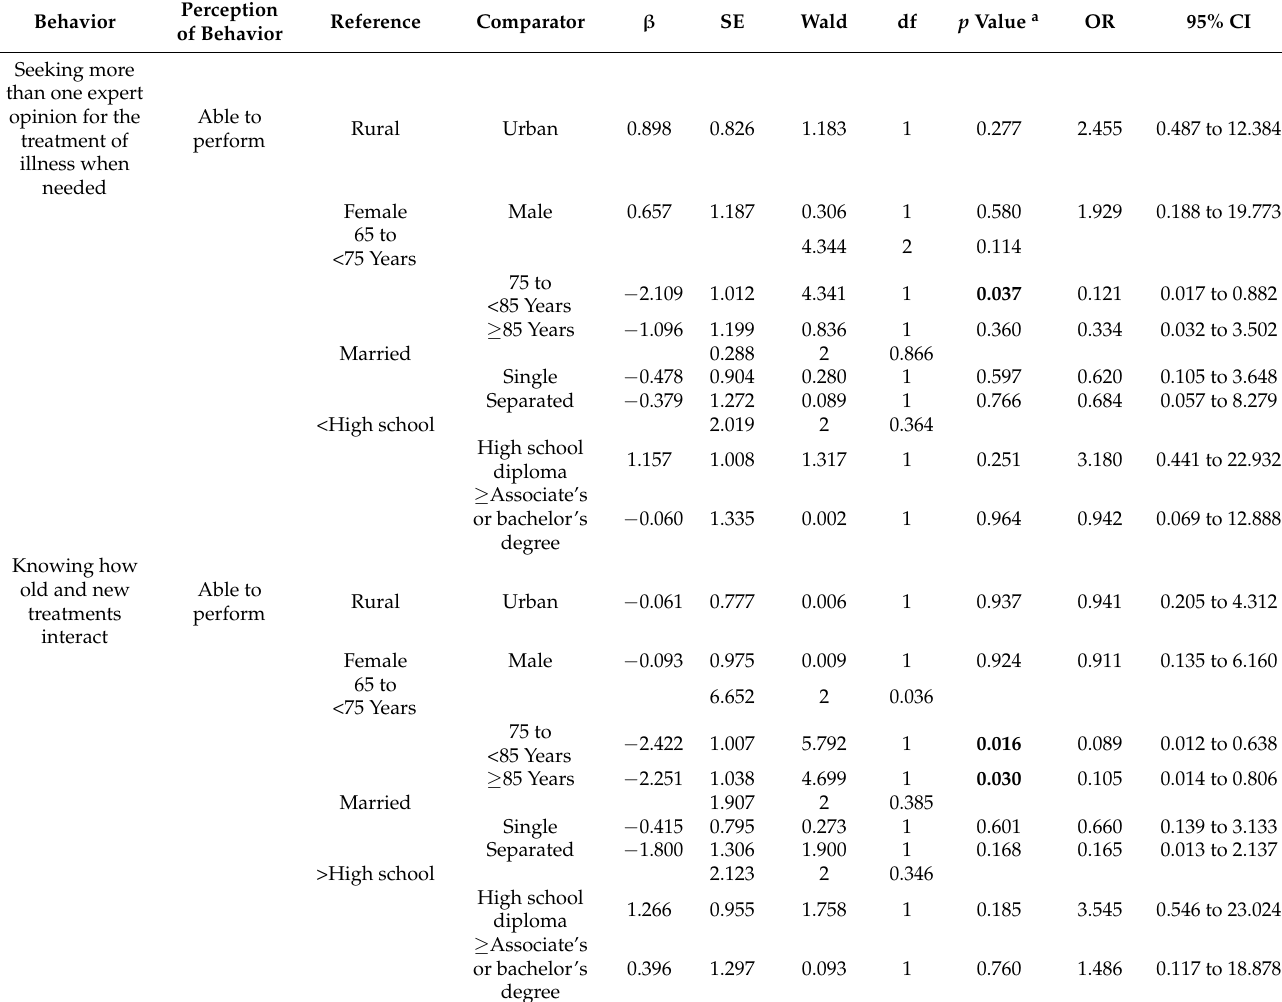
Table 4. Exploratory multivariate logistic regression models with at least one statistically significant regression coefficient value predicting the likelihood of a “yes” response to a perception about performing a self-care behavior.